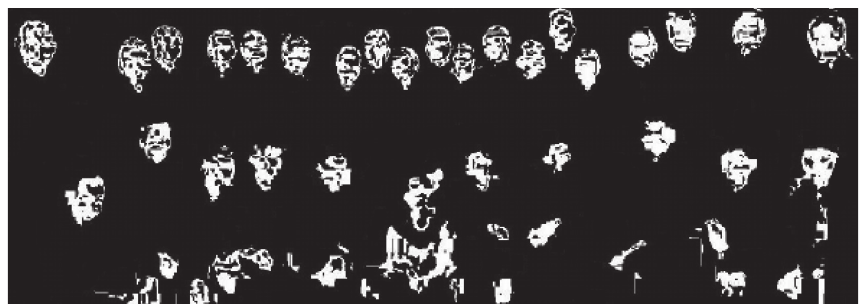
Figure 9: The binary image after morphological